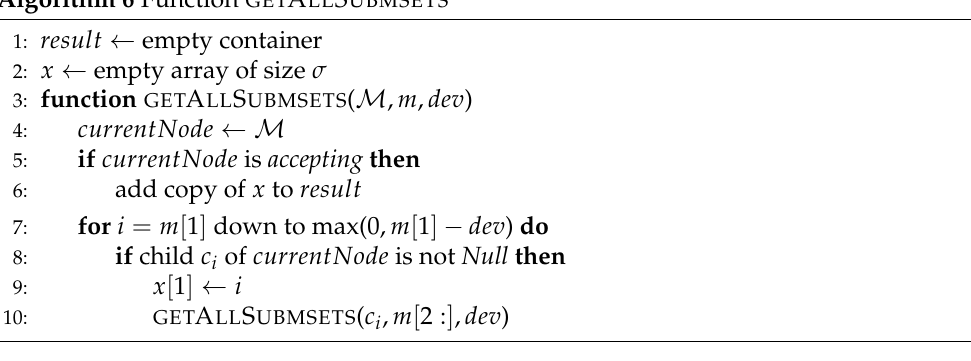
Algorithm 6 Function GET A LL S UBMSETS